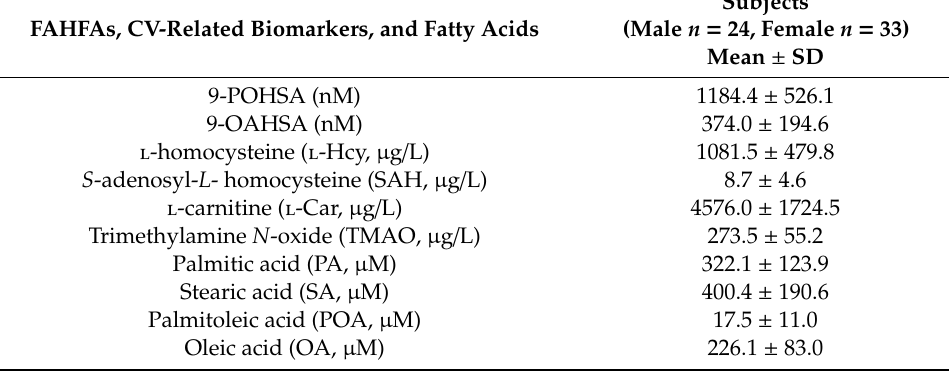
Table 2. FAHFAs, CV-related biomarkers, and fatty acid levels determined in healthy subjects by using